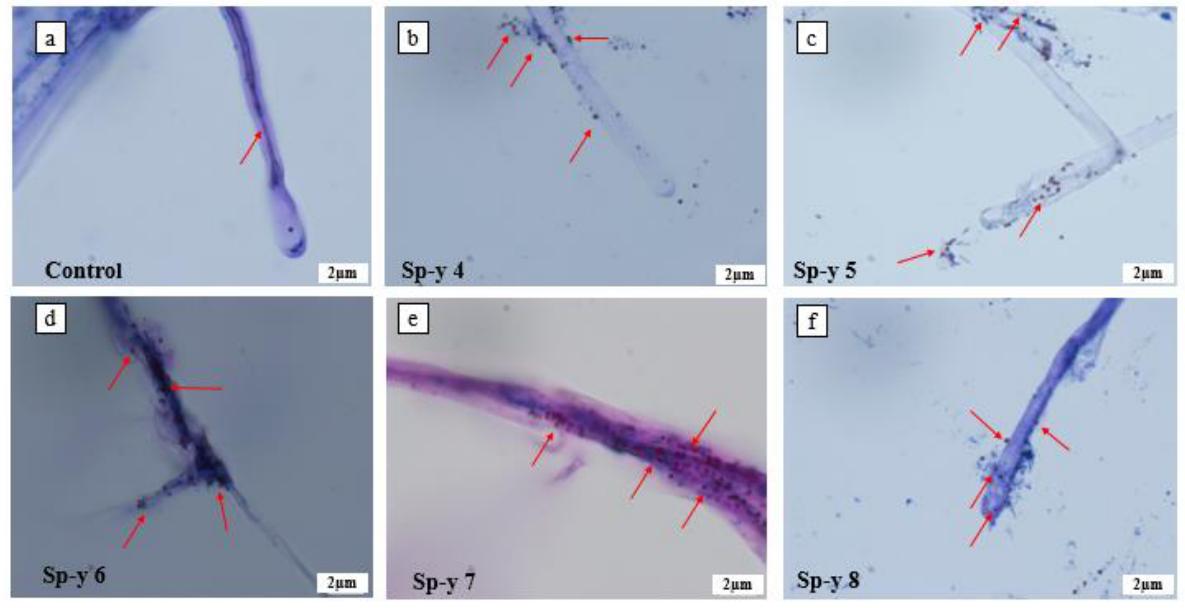
Figure 5. Microscopic visualization of rice hair surface with the presence of S. yanoikuyae SJTF8. ( a ) Root hairs of 10-day-old seedlings under control absent of bacteria. ( b ) Root hairs of 10-day- old seedlings treated with SP-y 4 showing the presence of the bacteria; ( c ) An increase in bacterial presence in the root hair of seedlings treated with SP-y 5; ( d ) A wide distributing of bacteria on the root hair of rice seedlings treated with SP-y 6; ( e ) Rice root hair treated with SP-y 7 also with a wide distribution of bacteria; ( f ) Notable presence of the bacteria on the root hair surface of rice seedlings treated with SP-y